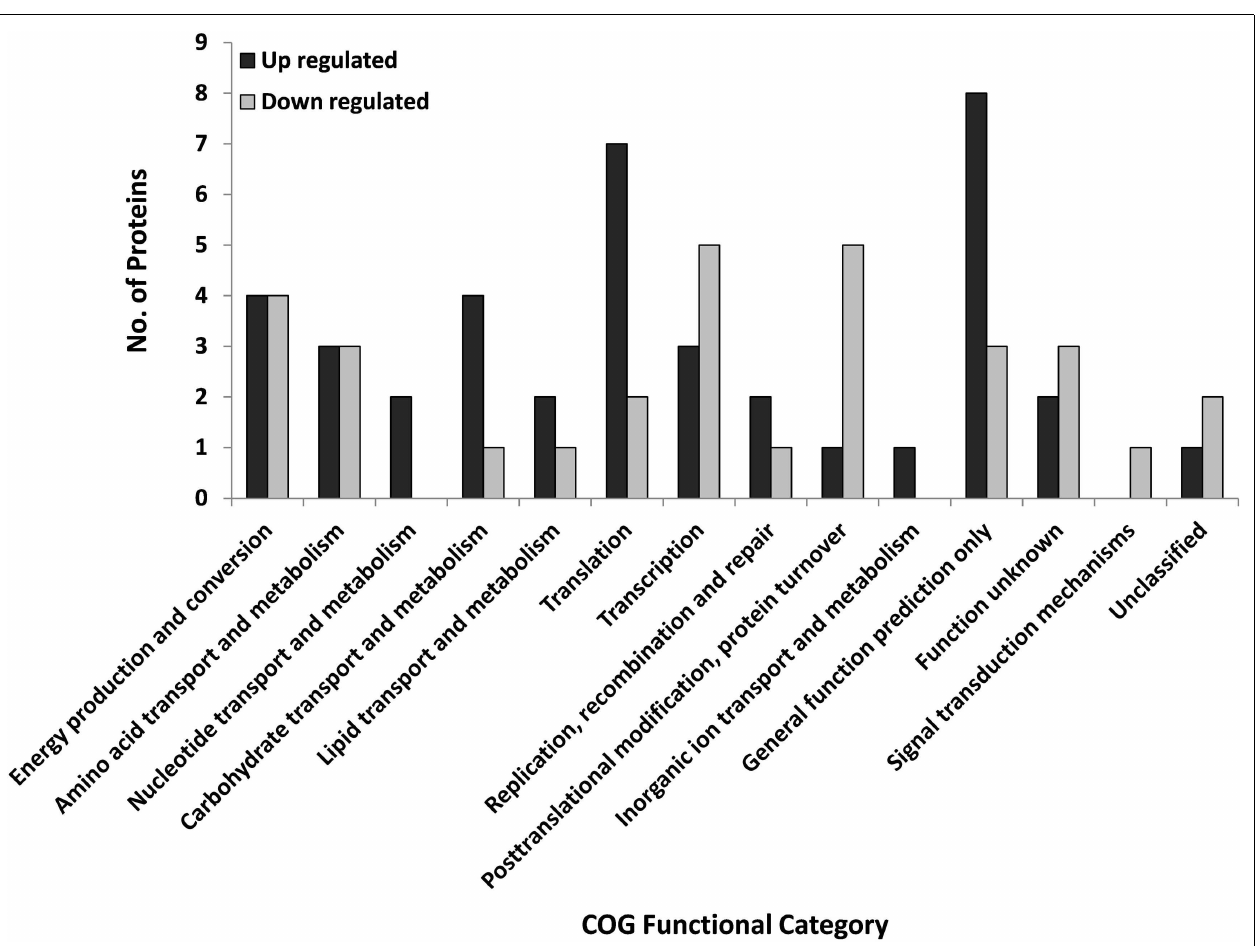
FIGURE 1 | Regulated S. solfataricus (P2) proteins by COG designation that were regulated during STIV infection. Proteins were classified as regulated if the fold change at any time point was ∼ twofold and p < 0.05 (ANOVA).There were 40 up-regulated and 31 down regulated